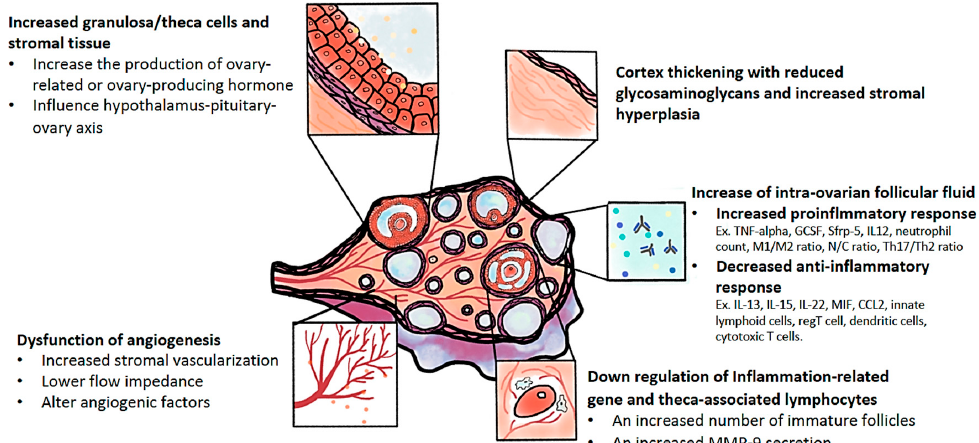
Figure 1. The pathophysiologic changes of polycystic ovary syndrome including cortical thickening and stromal hyperplasia; increased granulosa / theca cells and surrounding stromal tissues; increased intro-ovarian follicular fluid, such as an increased pro-inflammatory response and a decreased anti-inflammatory response; down-regulation and inflammation-related gene and theca-associated lymphocytes; and the dysfunction of angiogenesis within the ovary. All are apparently present in a polycystic ovary.